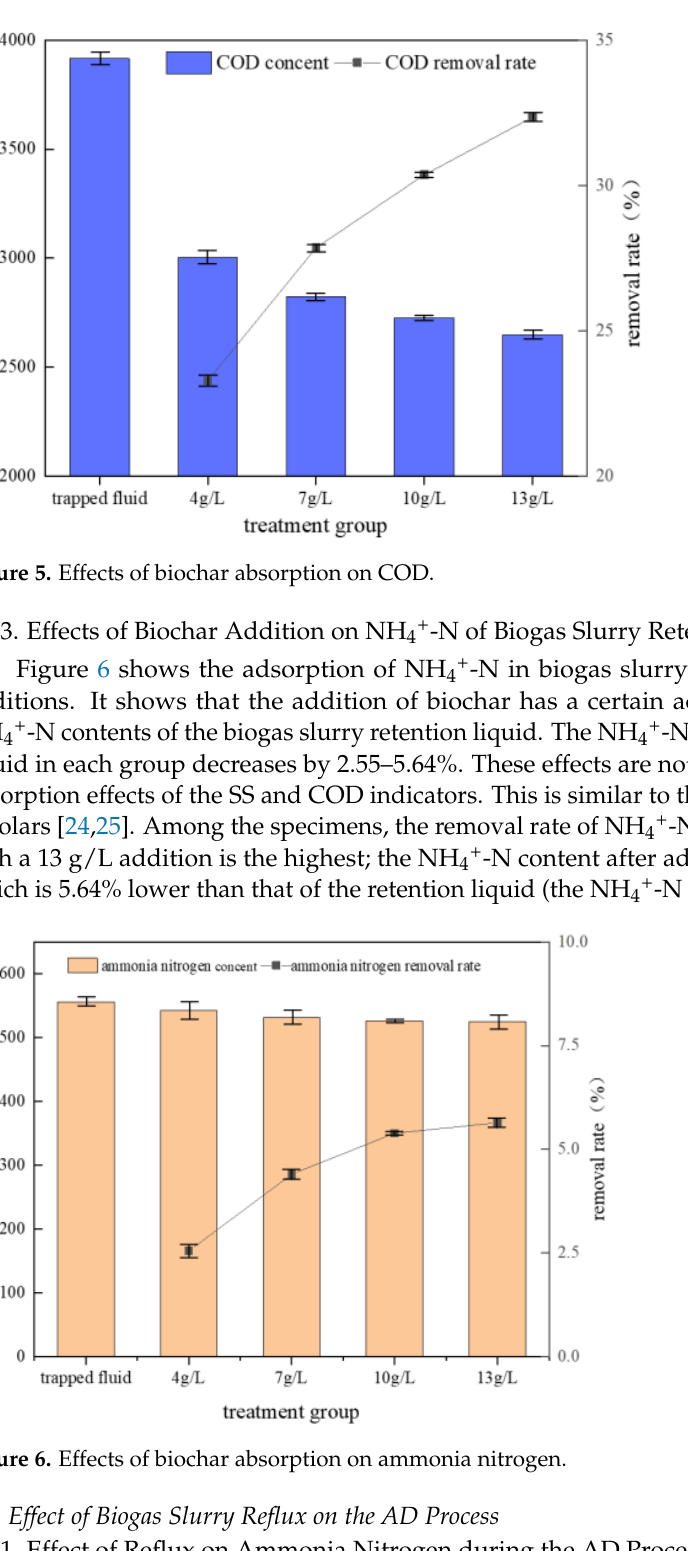
Figure 6. Effects of biochar absorption on ammonia nitrogen.